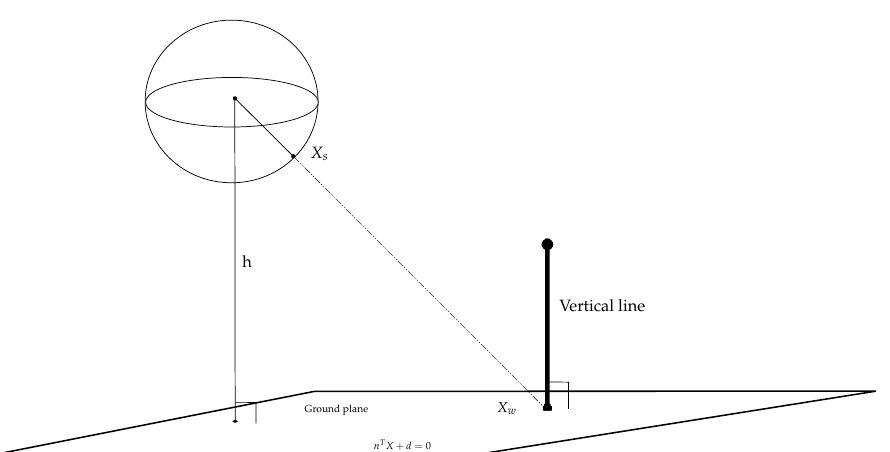
Figure 4. The image projection for the detection of the intersection (base point) from the corresponding vertical line.